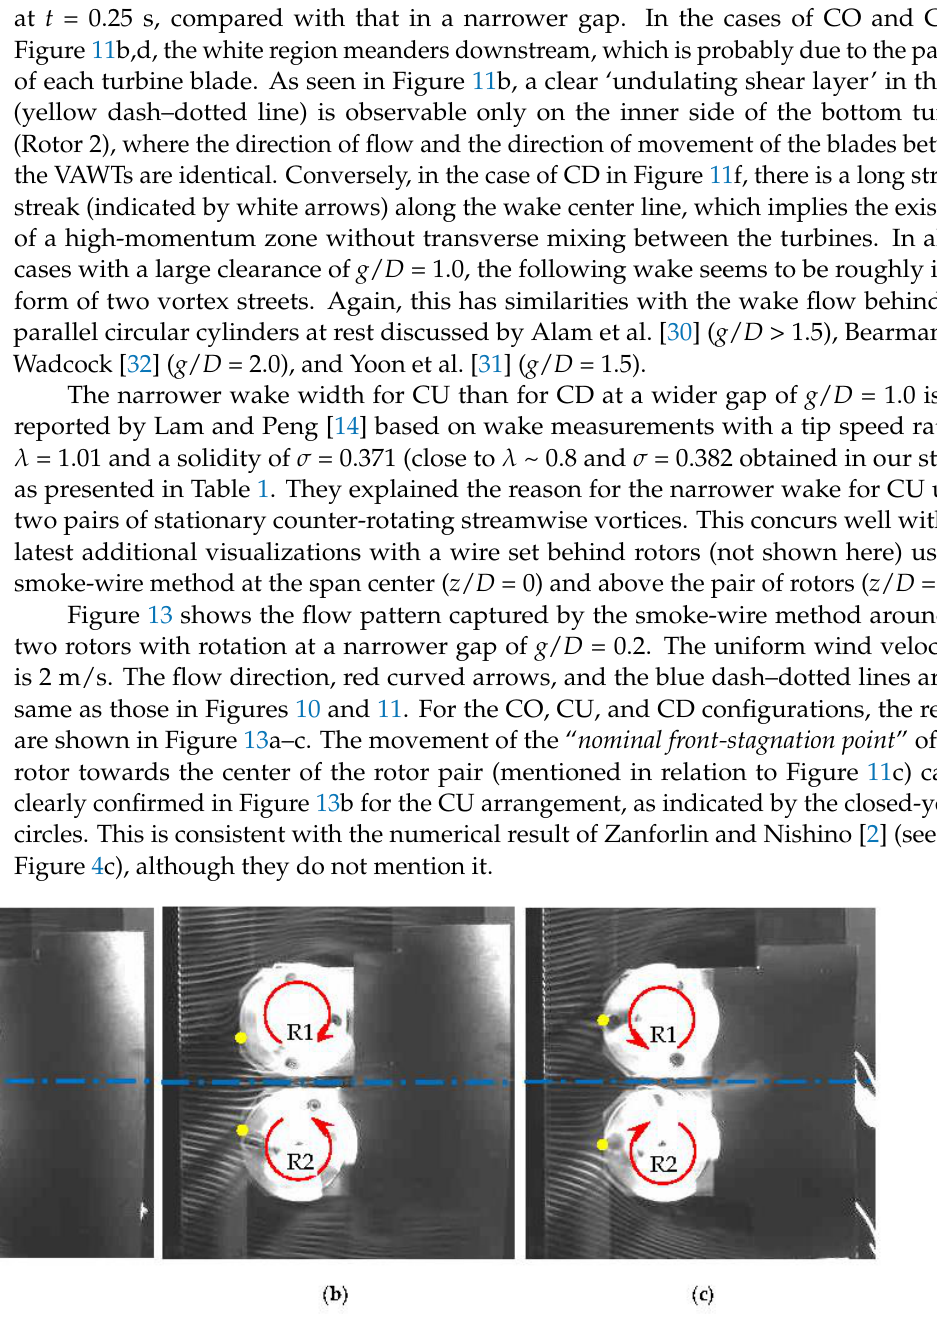
Figure 13. Photographs of smoke flow past two rotating turbines arranged side-by-side at g / D = 0.2 at t = 0.1 s under V = 2 m/s: ( a ) CO; ( b ) CU; ( c ) CD.